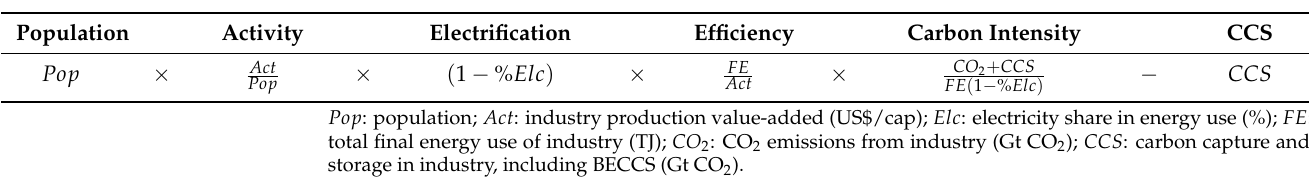
Table 2. Decomposition formula for industry.